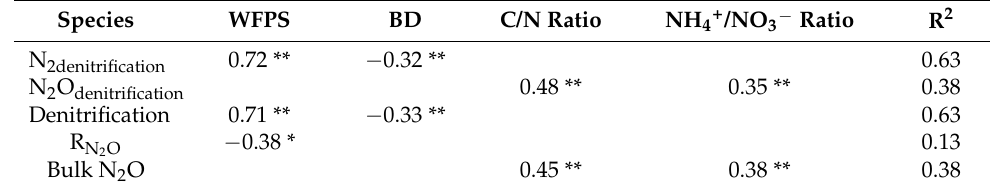
Table 4. Multiple linear regression models between fluxes, ratios of N 2 and N 2 O from denitrification, bulk N 2 O flux and selected soil properties in the mixed forest of Qingyuan station in Northeast